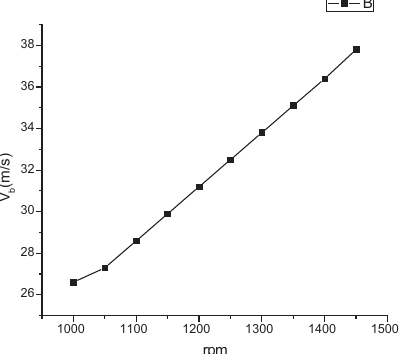
Fig. 6 . Plot of parallel capacitance vs. temperature as seen on